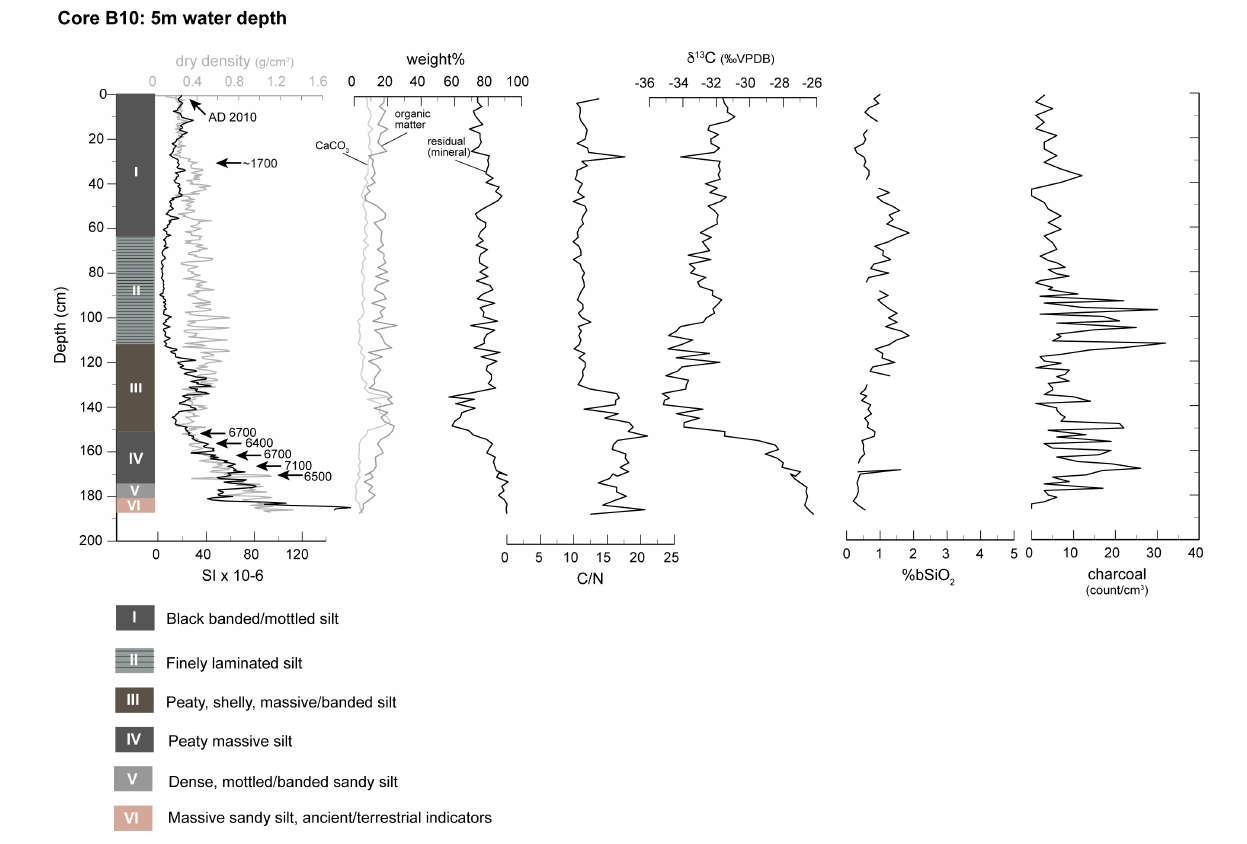
FIGURE 6 | Sediment core B lithology, physical and geochemical properties, and radiocarbon ages in cal yr BP (arrows): magnetic susceptibility (SI × 10 - 6 ), dry bulk density (g/cm 3 ), weight percentages (weight%) calcium carbonate (CaCO 3 ), organic matter, and residual mineral matter, organic C/N ratio, organic matter δ 13